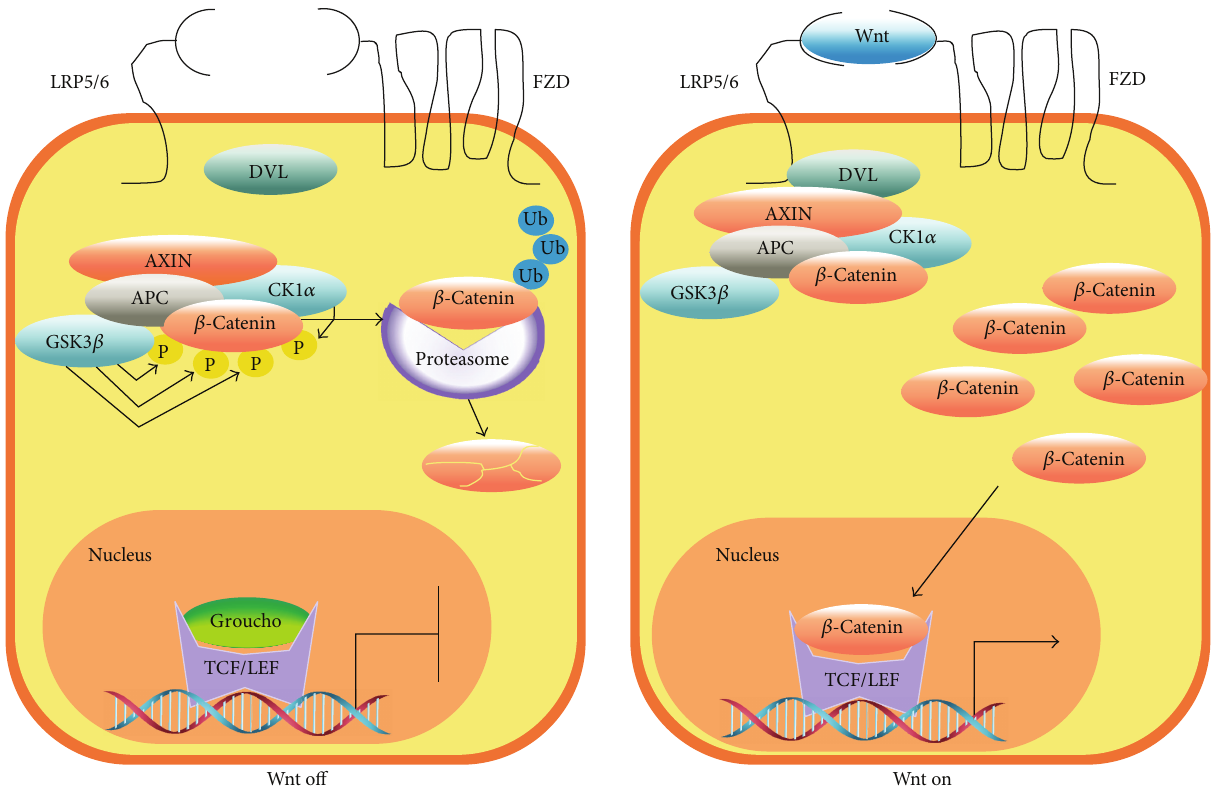
Figure 1: The Wnt/ 𝛽 -catenin pathway. In the absence of stimulus (Wnt off), 𝛽 -catenin is constantly phosphorylated by CKI 𝛼 and GSK3 𝛽 . These phosphorylations constitute a signal for 𝛽 -catenin polyubiquitination and hydrolysis by the proteasome 26S. In the presence of Wnt protein ligands (Wnt on), the destruction complex constituted by the proteins APC, Axin, CKI 𝛼 , and GSK3 is inactivated and 𝛽 -catenin, which is constantly synthetized, accumulates in the cytoplasm and nucleus where it interacts with TCF/LEF transcription factors to enhance expression of specific